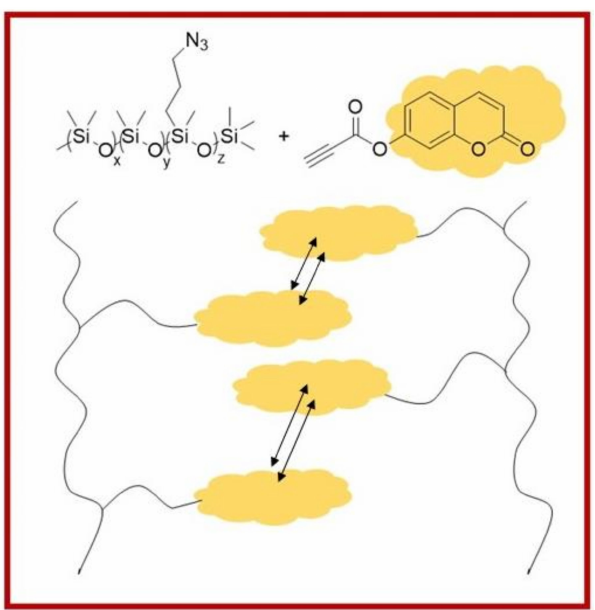
Figure 20. Coumarin as functional groups in thermoplastic